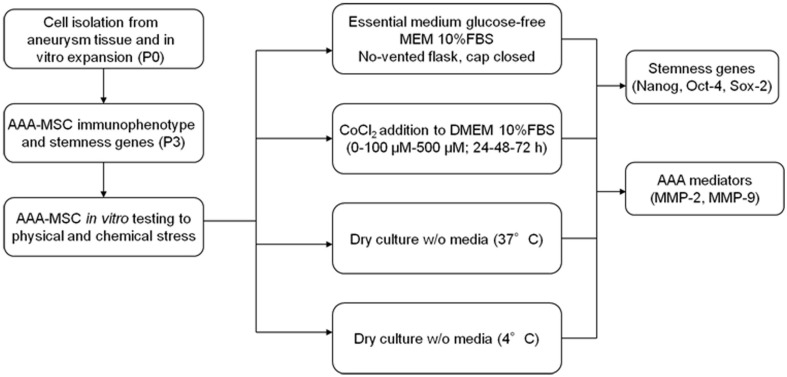
Experimental design.